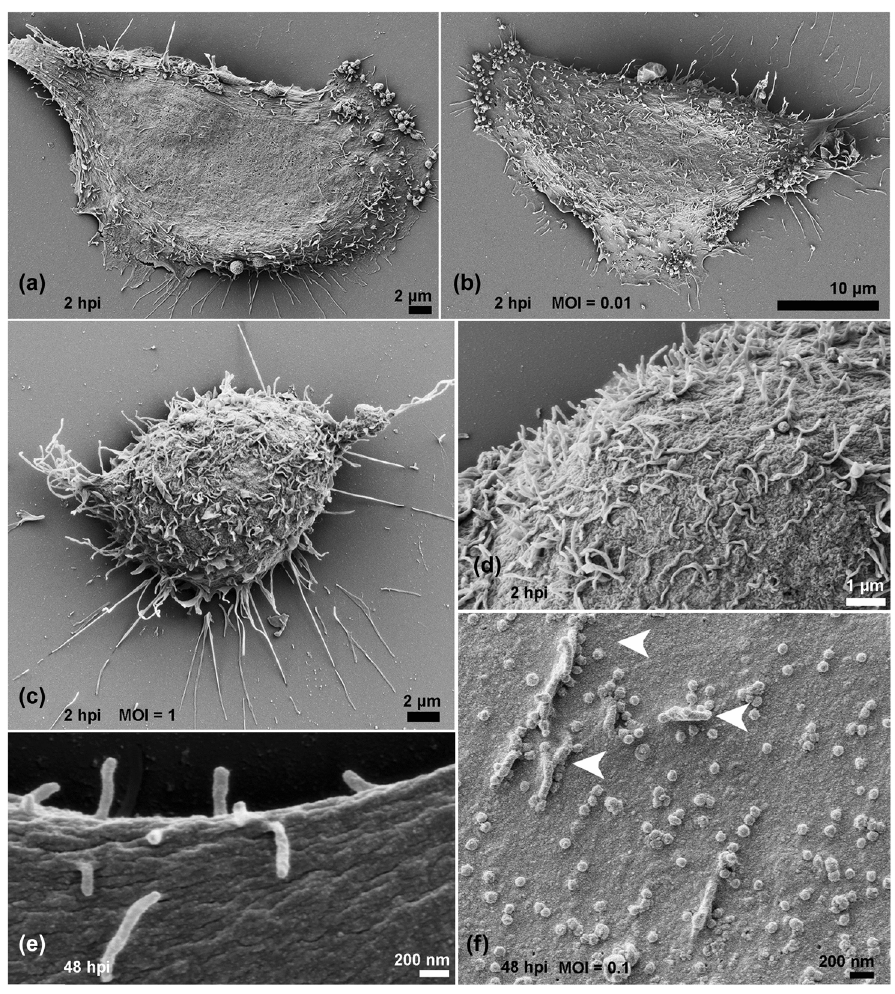
Figure 7: Discrete increment of the SP with mocked and infected cells of ( a – f ) [ 77 ]